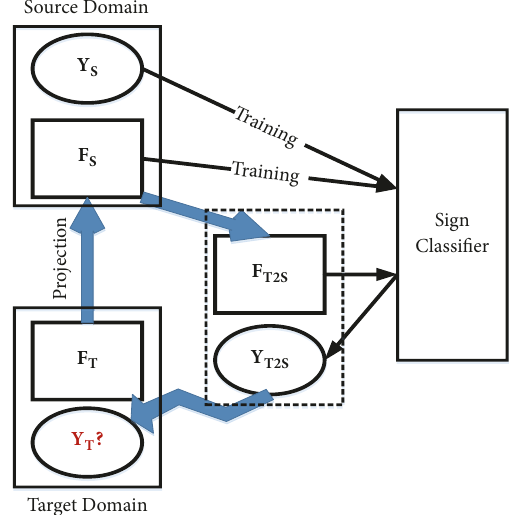
Figure 1: Collaborative representation of the source domain knowl- edge and the target domain knowledge for sign